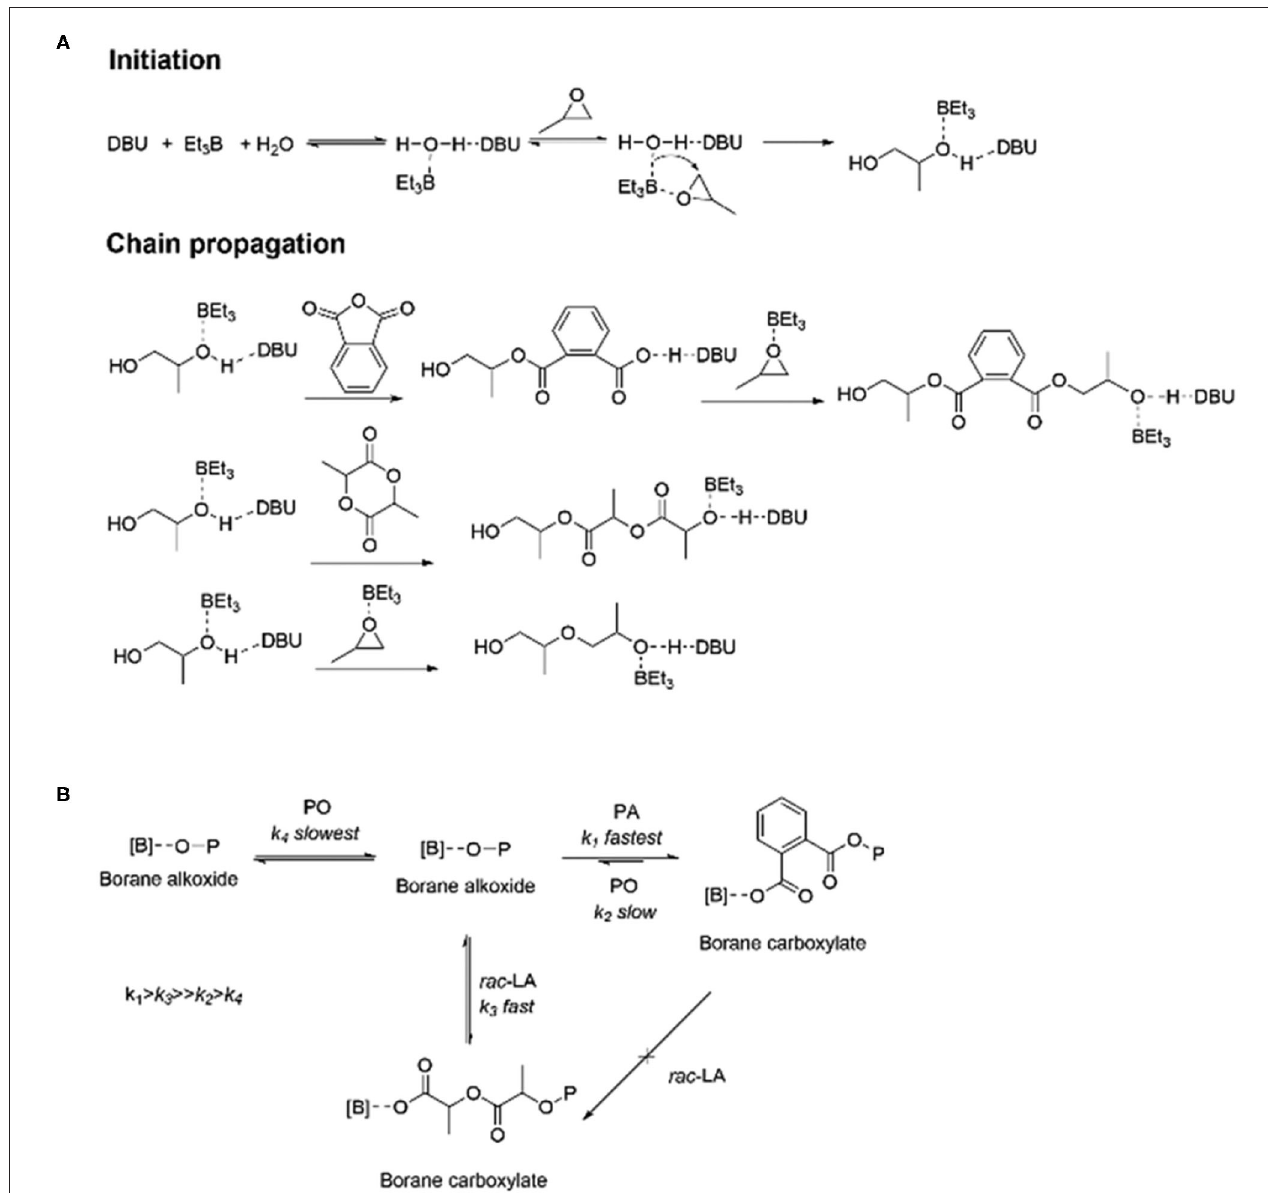
FIGURE 10 | Plausible mechanistic aspects for the highly selective polymerization process: H 2 O-initiated ROCOP and ROP catalyzed by the TEB (Et 3 B)/DBU pair (A) and sequence controlled polymerization from monomer mixtures (B) . ROCOP, ring-opening copolymerization; ROP, ring-opening polymerization; TEB, triethyl borane; DBU, 1,8-diazabicyclo[5.4.0]undec-7-ene; LLA-OCA, L -lactide- O -carboxyanhydride. Adapted with permission from Zhu et al. (2020). Copyright 2020 The Royal Society of